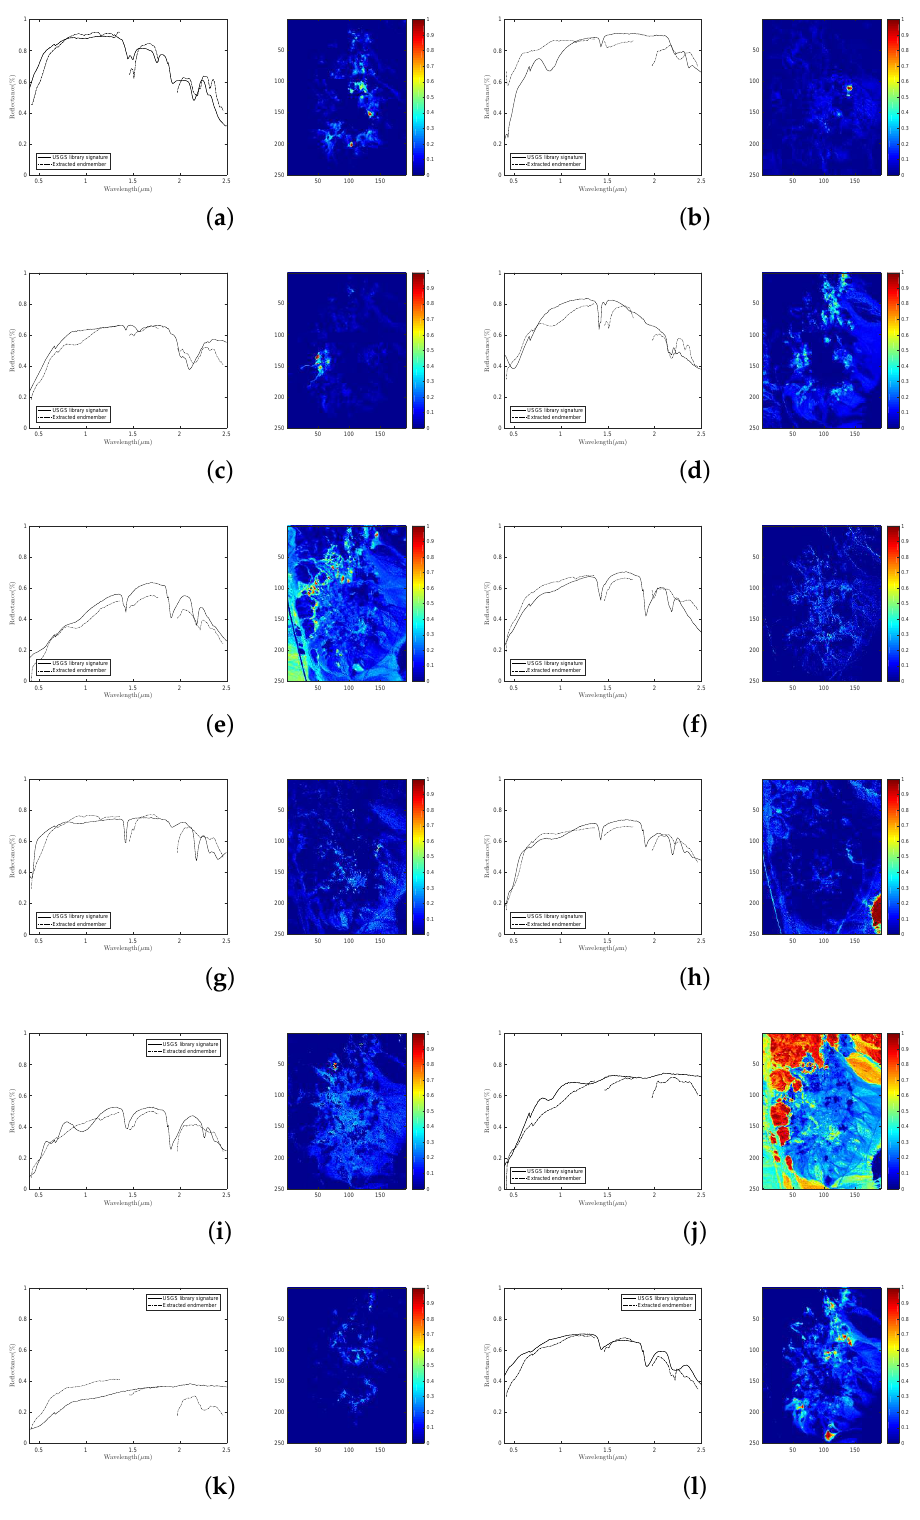
Figure 15. The extracted endmembers by DGC-NMF and their corresponding United States Geological Survey (USGS) library signatures, along with the estimated abundance maps. ( a ) alunite; ( b ) andradite; ( c ) buddingtonite; ( d ) dumortierite; ( e ) kaolinite #1; ( f ) kaolinite #2; ( g ) muscovite; ( h ) montmorillonite; ( i ) nontronite; ( j ) pyrope; ( k ) sphene; and ( l )